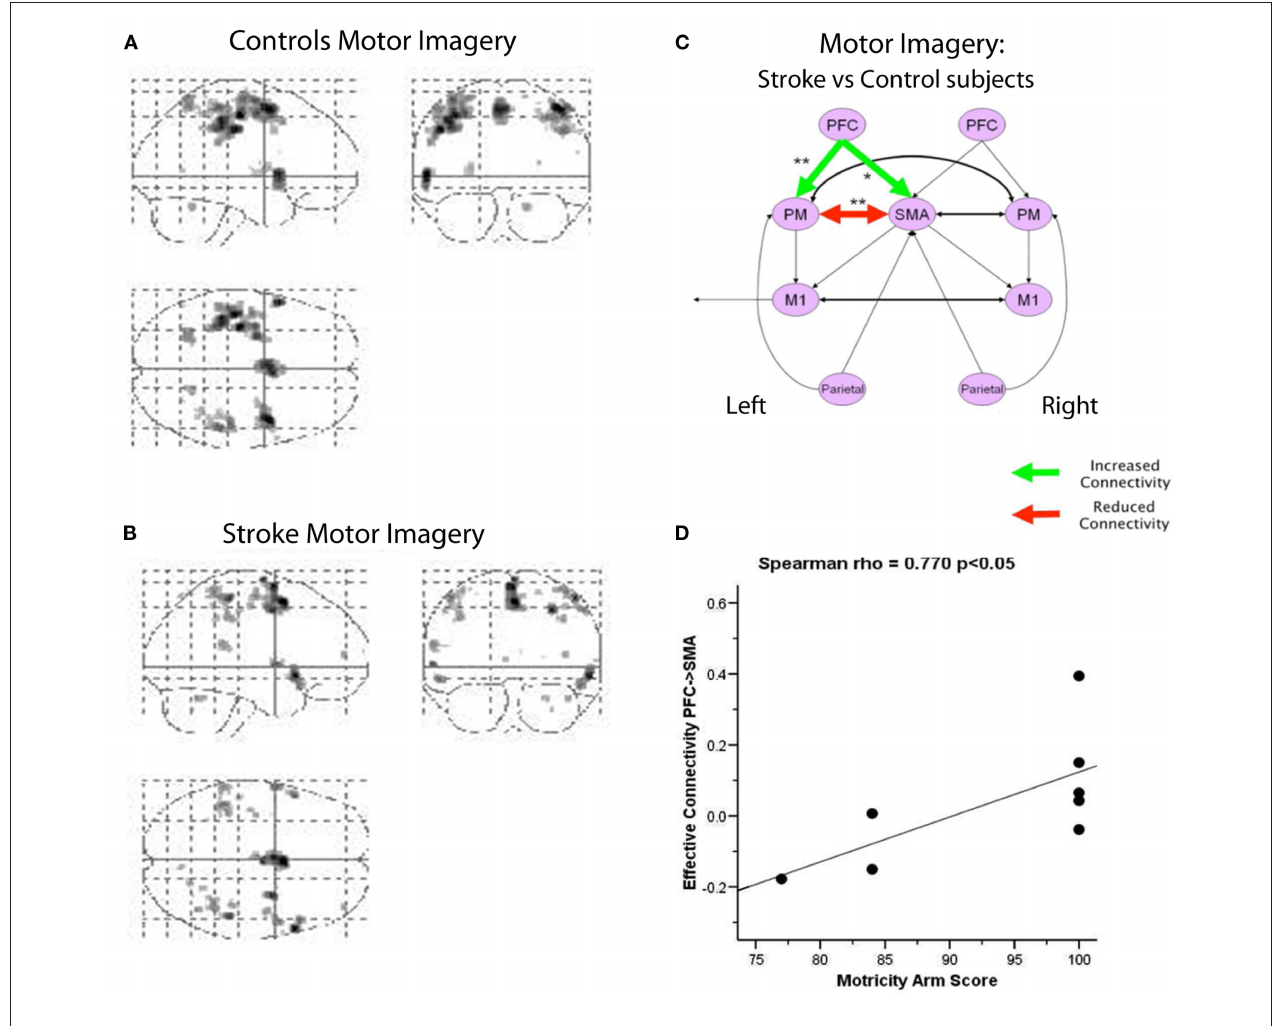
FIGuRe 3 | During the imagination of movement, healthy subjects (A) and patients with subcortical strokes (B) show similar patterns of voxel-wise activation during fMRI, with no significant group differences in regional activations. However, Structural equation modeling of fMRI data revealed persisting abnormities of connectivity between groups